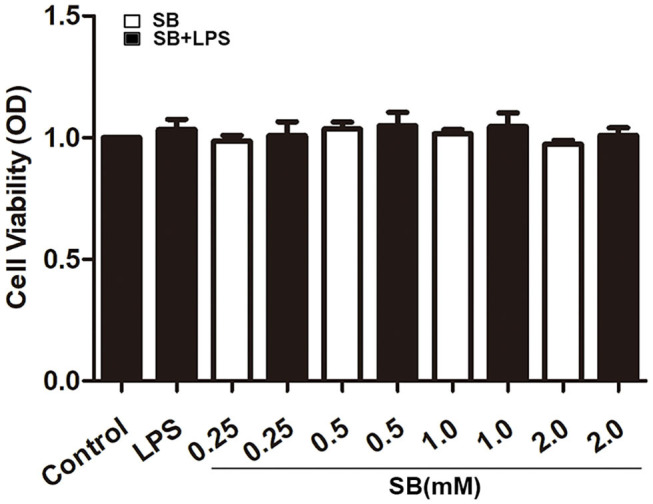
Effect of sodium butyrate on the viability of bovine macrophages. Bovine macrophages incubated with different concentrations of sodium butyrate (0.25, 0.5, 1, 2 mM) for 15 h, then stimulated with 5 μg/ml LPS for 3 h. The cell viability was assayed by CCK-8 method. Values were shown as means ±SD (n = 5).